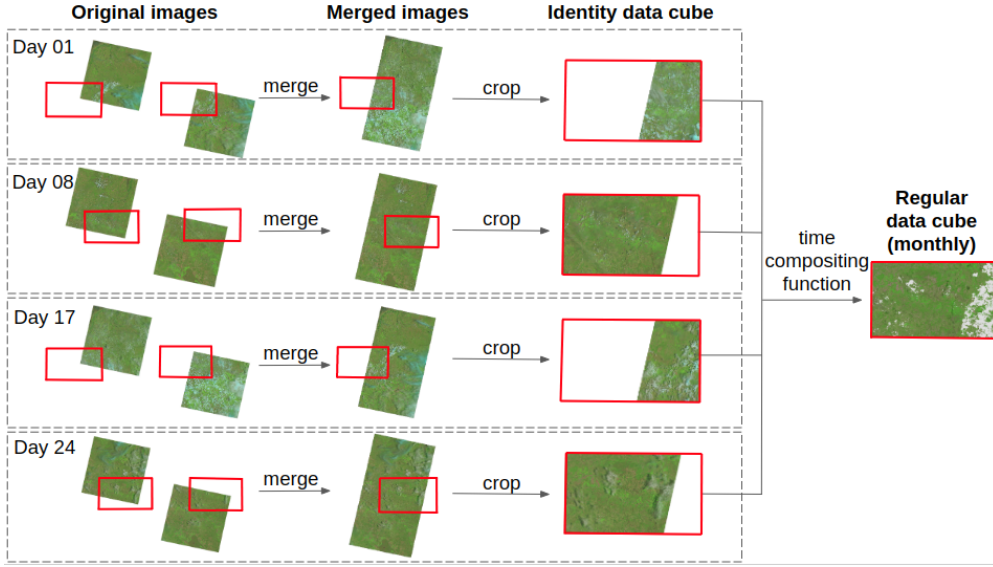
Figure 4. The process to generate a monthly regular data cube, considering a grid